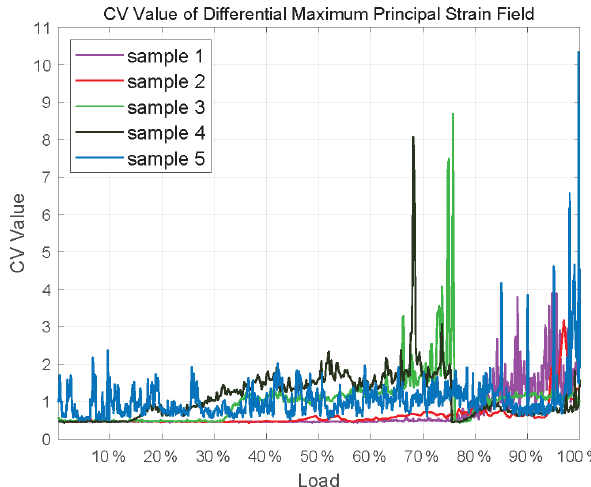
Figure 7. The CV of differential maximum principal strain fields for the five samples. The colored lines represent the CV calculated by differential maximum principal strain fields of different